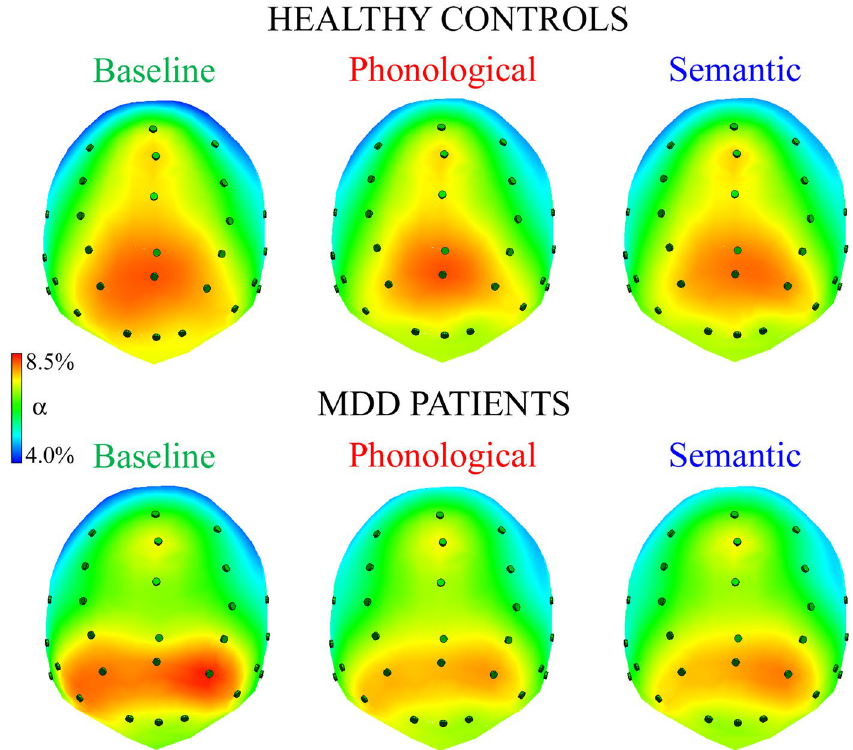
Figure 2. Spline maps of normalized alpha amplitudes during resting state, baseline condition (left panel), phonological and semantic linguistic tasks (middle and right panels, respectively) in HC and MDD patients. Qualitative analysis of spline maps suggests that, regardless of group, participants had bilateral alpha activity and greater levels in posterior regions, particularly in the baseline (control